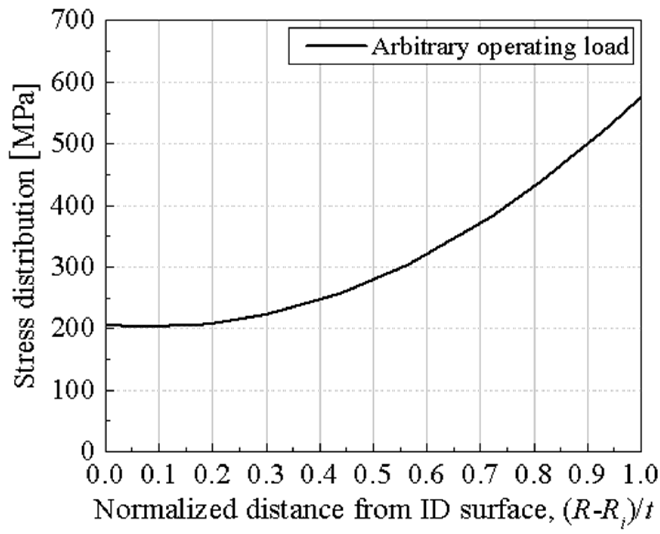
Figure 11. Stress distribution in the thickness direction applied to the pipe.